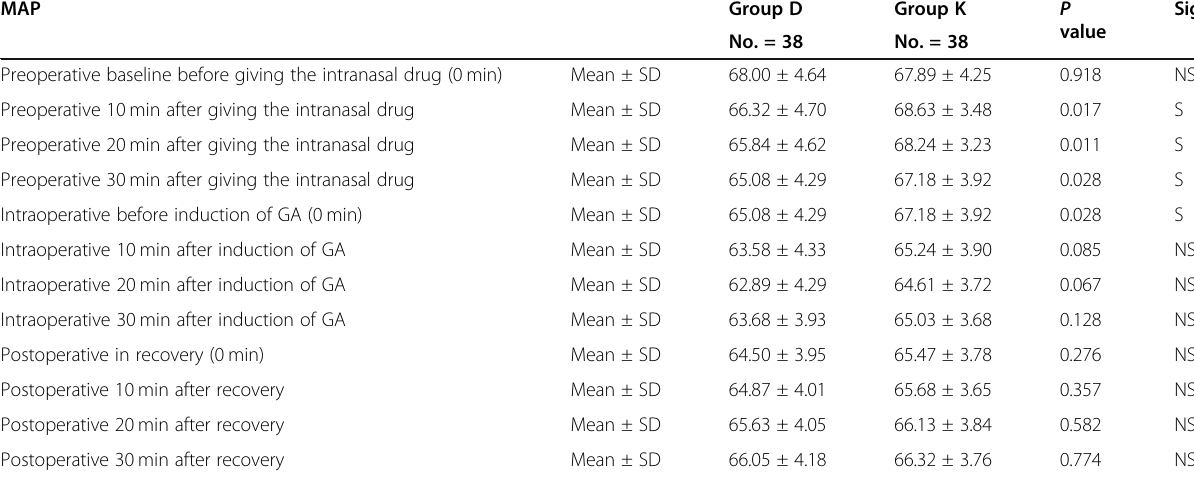
Table 7 Comparison between group D and group K as regards mean arterial pressure (MAP) MAP Group